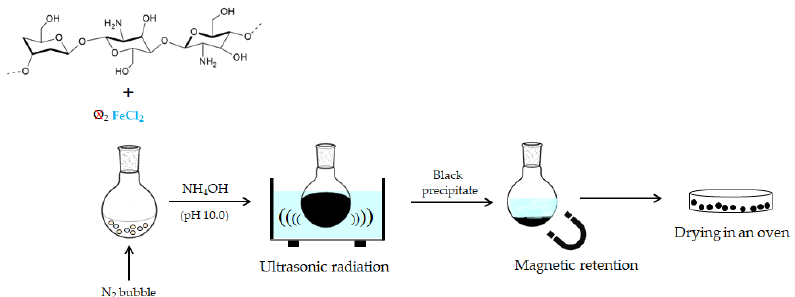
Figure 1 . Scheme of synthesis of chitosan-based magnetic adsorbent. Figure 1. Scheme of synthesis of chitosan-based magnetic